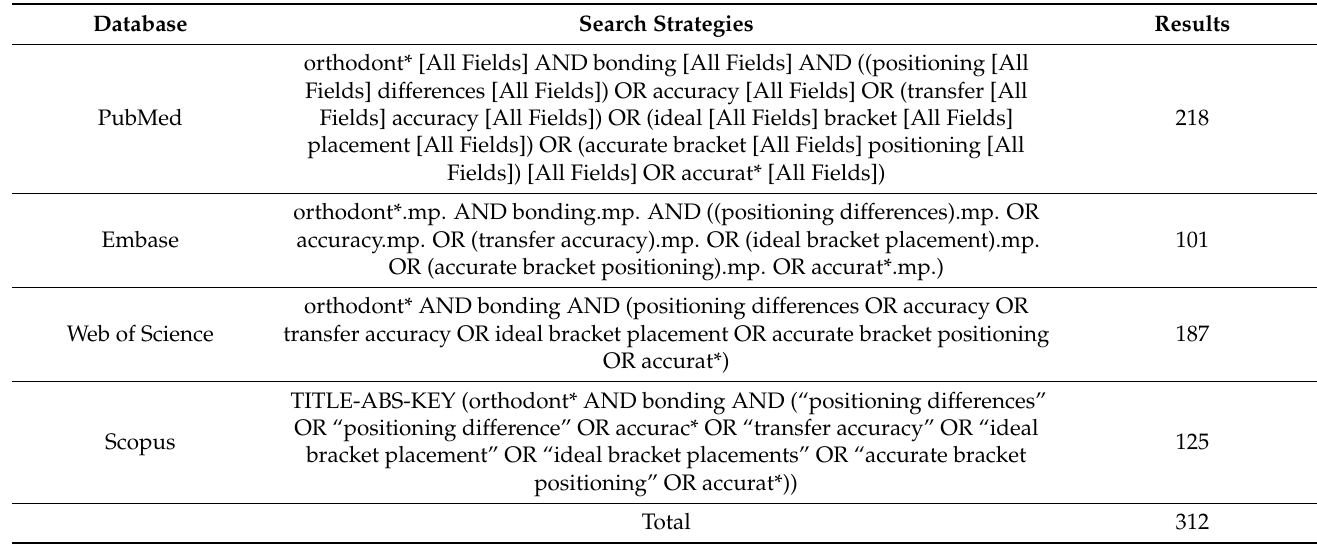
Table 2. List of adapted search strategies used for different databases and number of identified